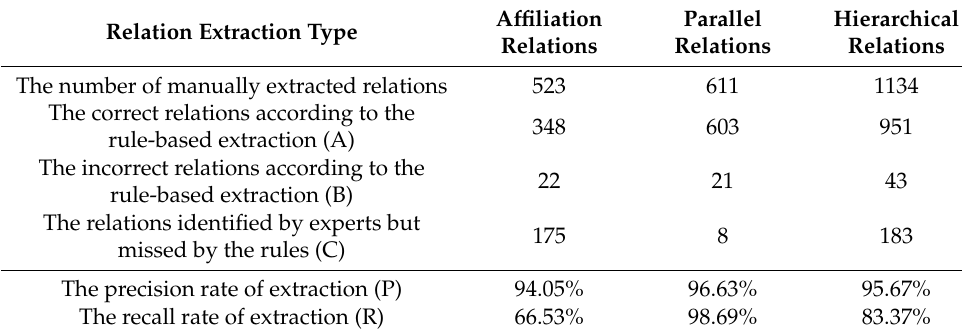
Table 4. Rule inspection results.